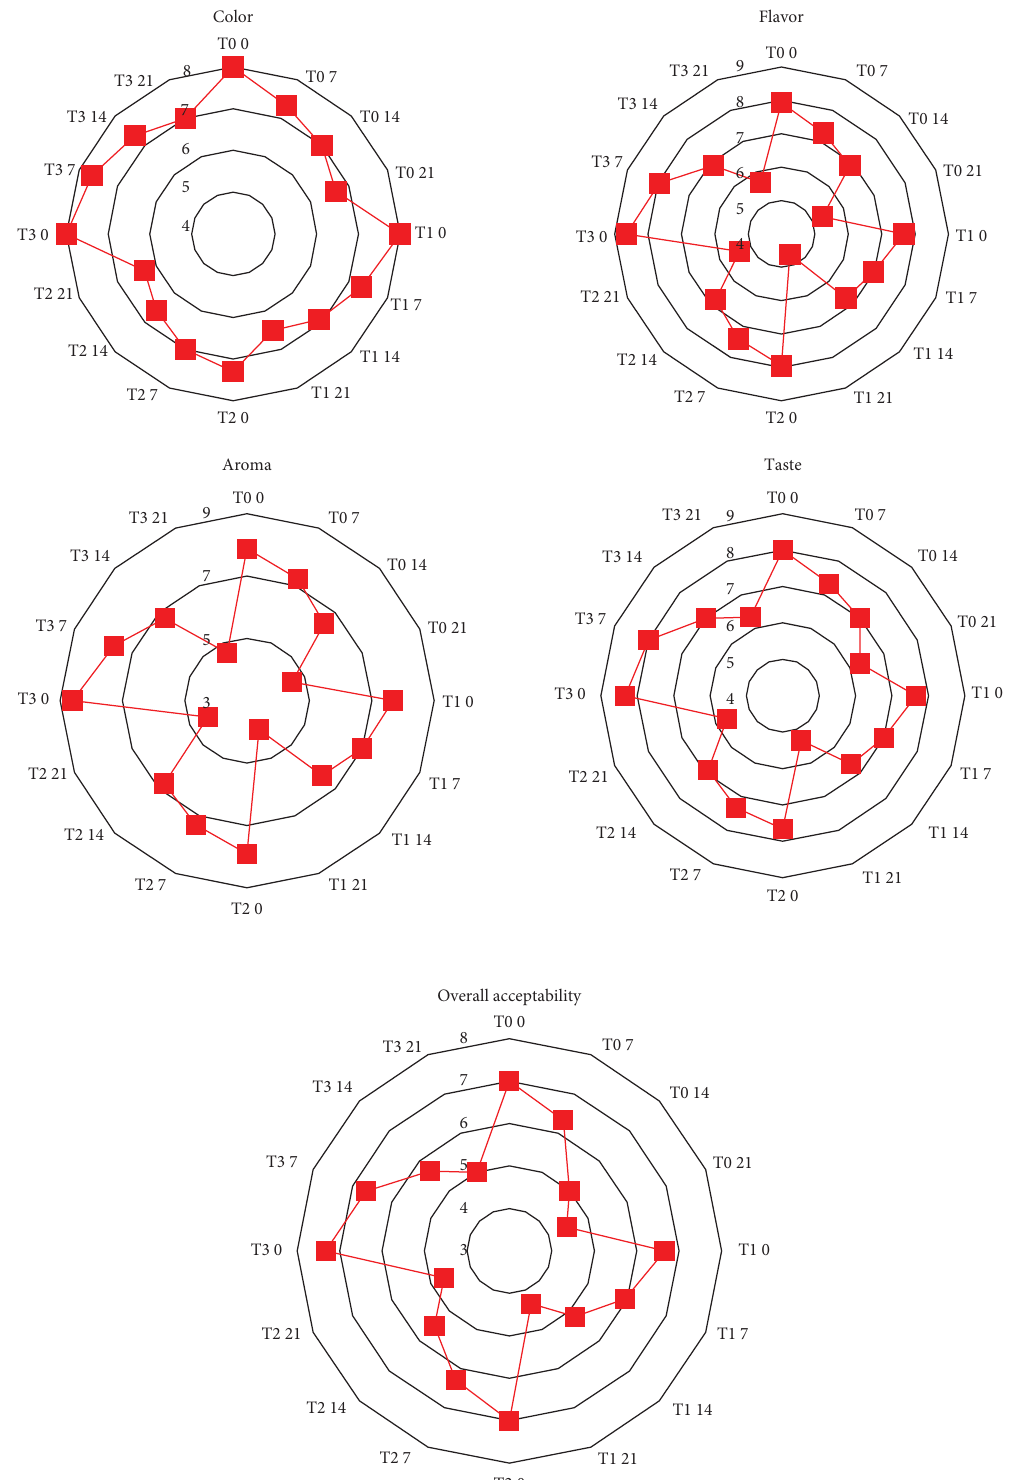
Figure 3: Sensory evaluation of free and encapsulated L. rhamnosus- treated probiotic orange juice at 0, 7, 14, and 21days T juice; T 1 � free L. rhamnosus ; T 2 � sodium alginate (1.5%)-encapsulated L. rhamnosus ; T 3 � sodium alginate (1.5%)- and xanthan gum (0.5%)-encapsulated L. rhamnosus